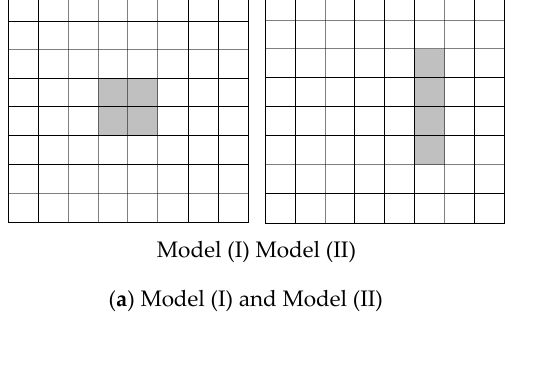
Figure 7. Non-dimensional deflections according to positions for sensor/actuator pairs through the thickness.